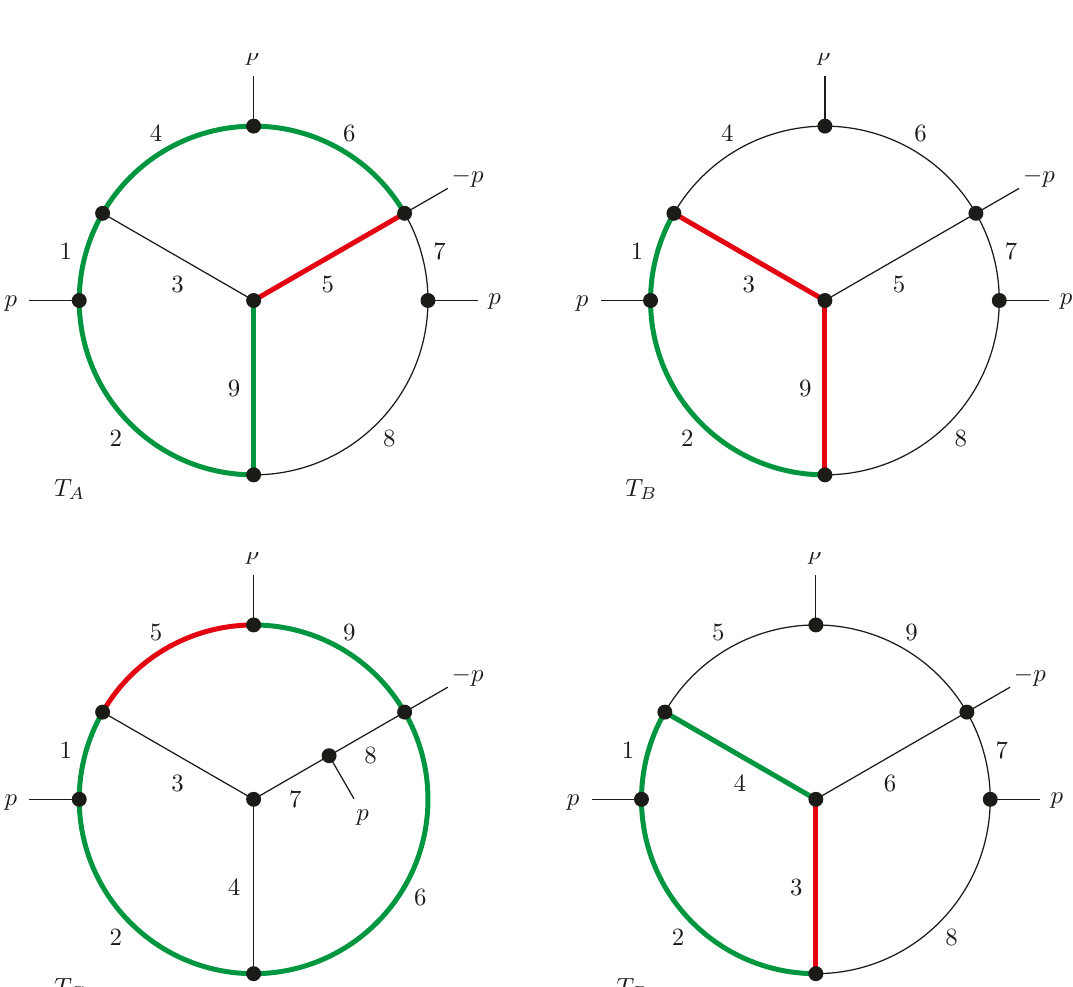
Figure 2 . Graphs for the four topologies. The internal masses of the propagators are encoded by the colour of the propagators: massless (black), m t (green), m W (red).